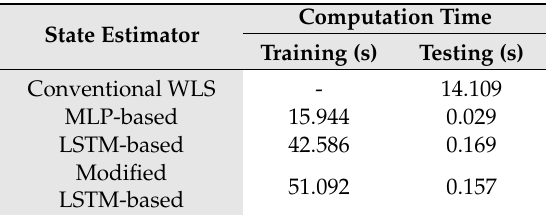
Table 3. Computation times of state